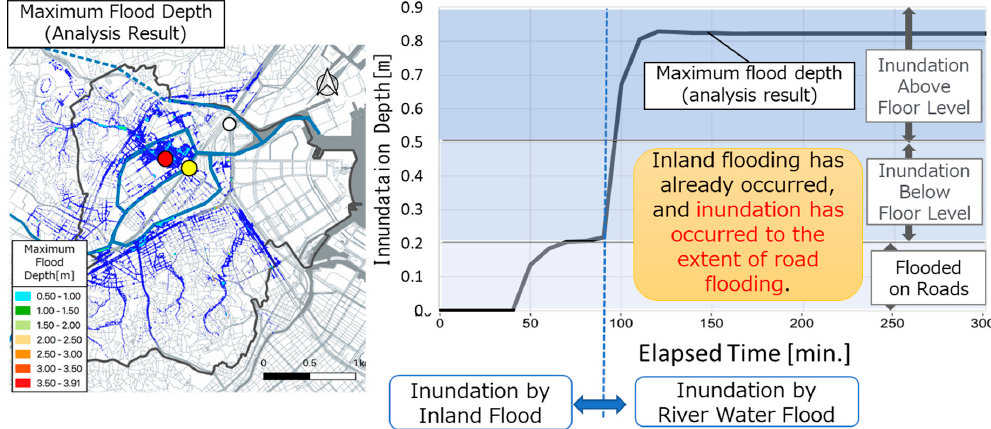
Figure 15. Chronology of inundation depth during the simultaneous occurrence of river water/inland